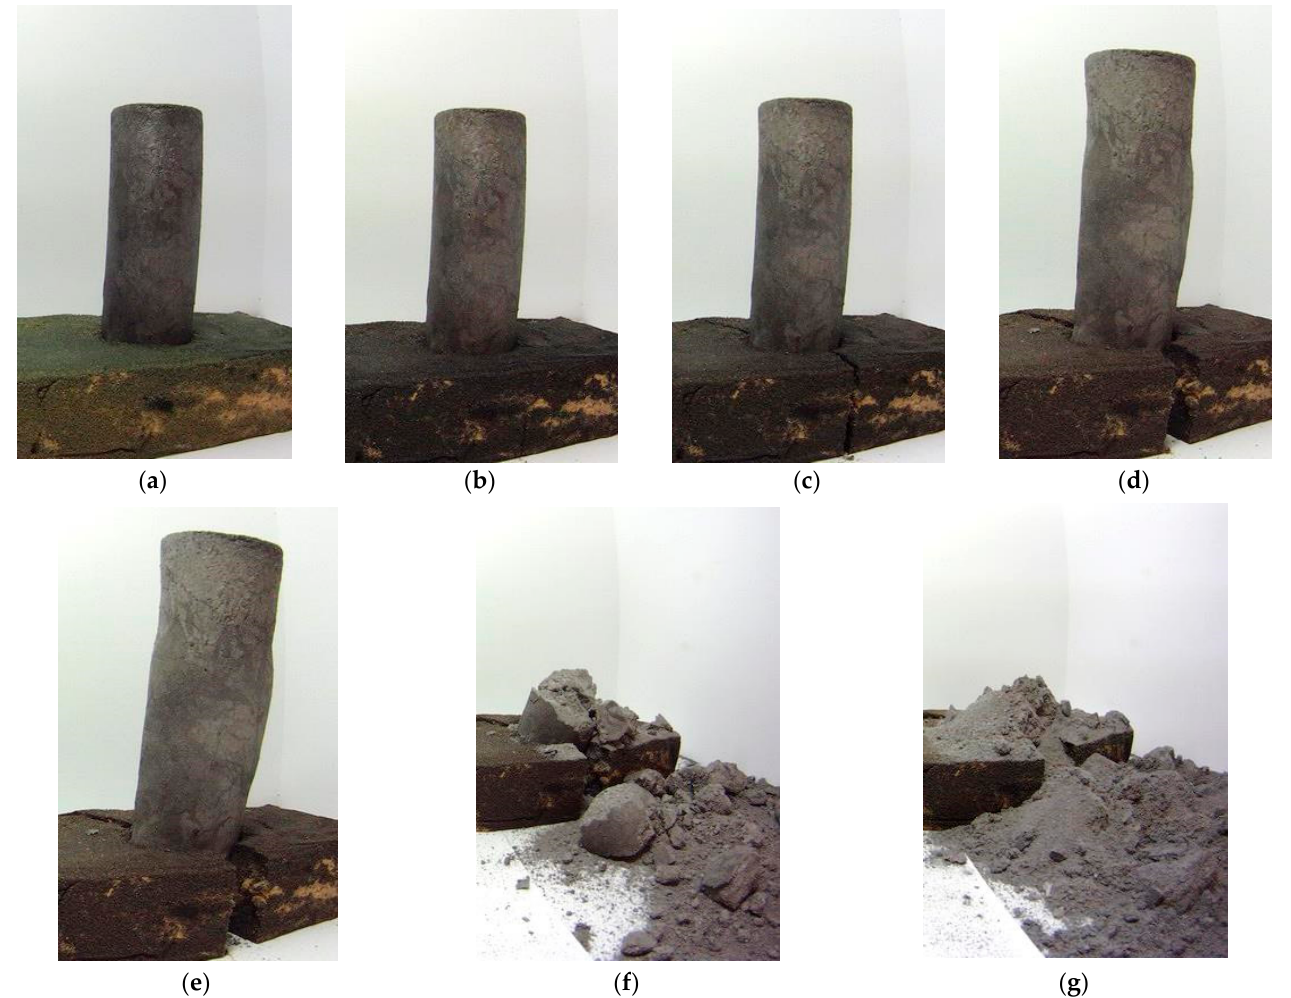
Figure 3. High-aluminum cast iron samples—photos taken after 1 day ( a ), 9 days ( b ), 12 days ( c ), 18 days ( d ), 20 days ( e ), 21 days ( f ), 31 days ( g ).